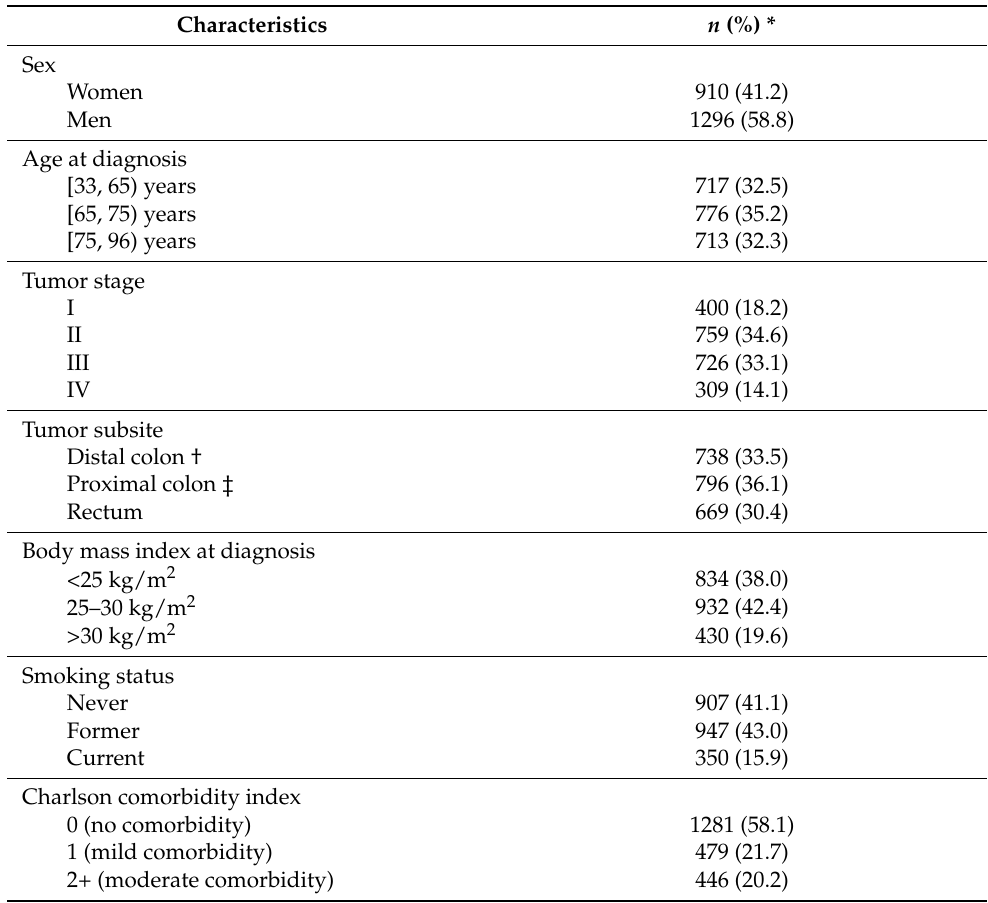
Table 1. Baseline characteristics of the patient